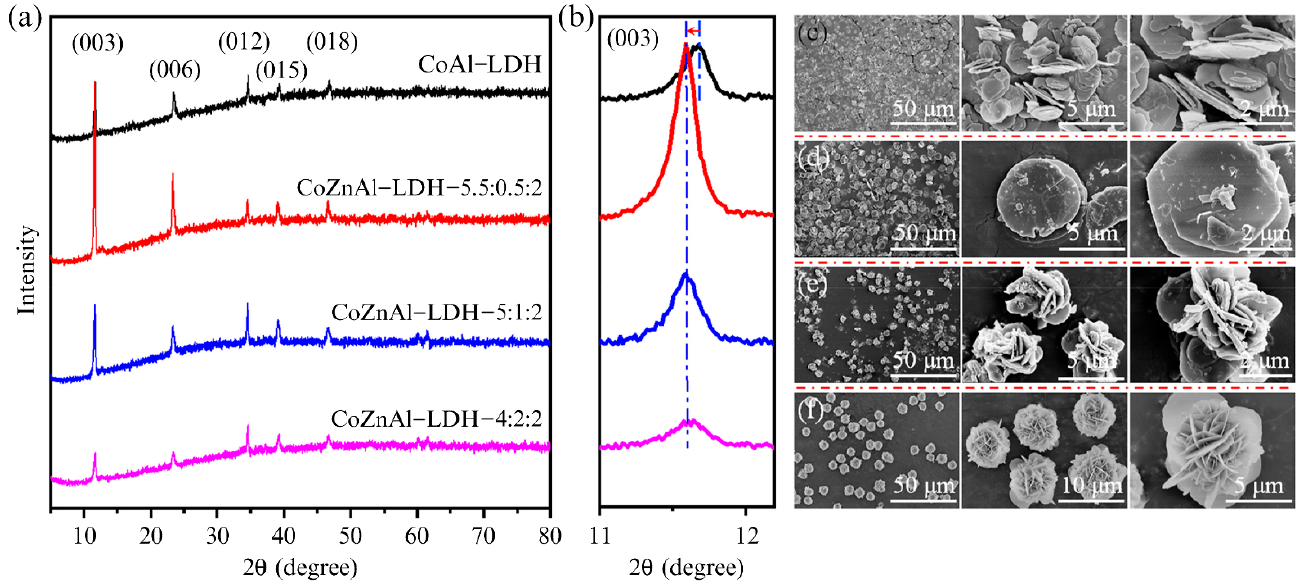
Figure 12. ( a ) XRD patterns; ( b ) selected XRD pattern insets of the (003) diffraction peak; and ( c – f ) corresponding FESEM images for CoAl − LDH, CoZnAl − LDH − 5.5:0.5:2, CoZnAl − LDH − 5:1:2, and CoZnAl − LDH − 4:2:2, respectively. Reproduced with permission from [85].